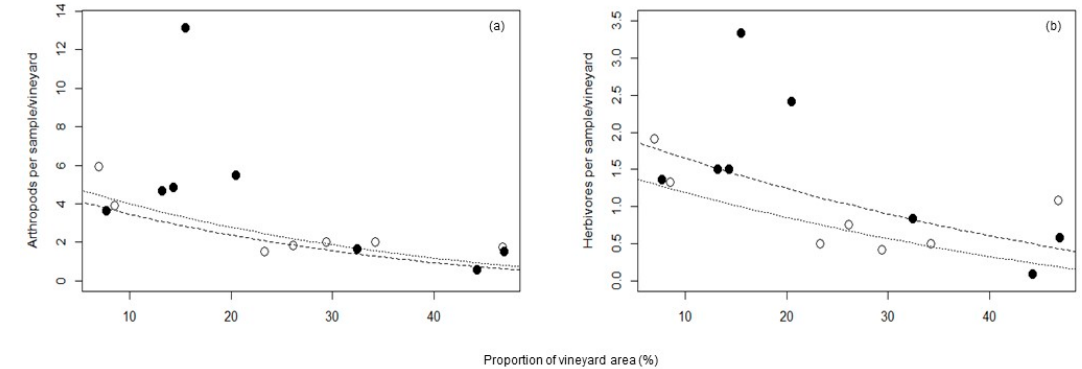
Figure 2. Model predictions and influence of landscape factors on the mean abundance of: ( a ) total arthropods; ( b ) the herbivore group. Dashed lines/black symbols represent the abundance of individuals in vineyards with vegetation cover, dotted lines/white symbols in vineyards with bare soil.